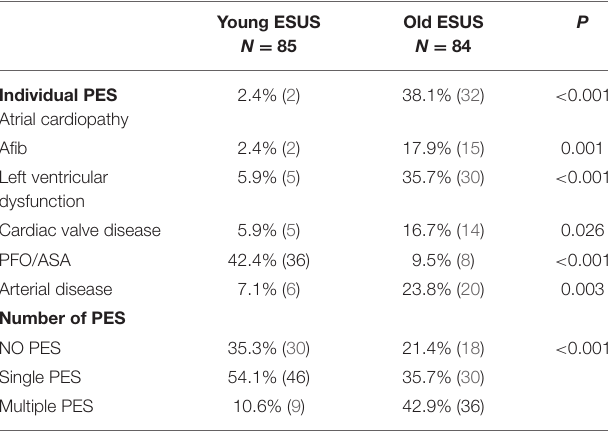
TABLE 3 | Rate of PES by types and